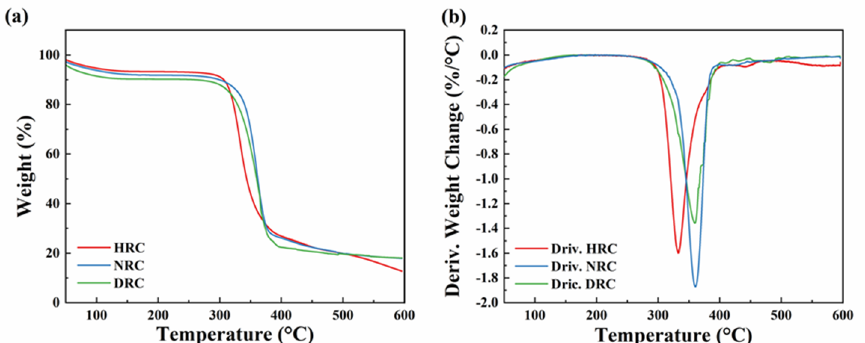
Figure 5. Stress–strain curves of regenerated cellulose films from three solvent systems. TGA and DTG curves are depicted in Figure 6. The initial weight loss at about 100 °C was due to the dehydration of regenerated films [47]. The main weight loss occurred in the range of 300–390 °C, corresponding to cellulose thermal decomposition and carboni- zation [33] and urethane hard segment degradation [48]. The maximum decomposition temperatures (T max ) of HRC, NRC, and DRC films were 332.68, 360.26, and 359.97 °C, respectively. Among them, the NRC and DRC films exhibited relatively higher T max values, which might be attributed to the higher cellulose concentration in NaOH/urea solution [40] and the dissolution of elastane fibers in LiCl/DMAc solvent [49].